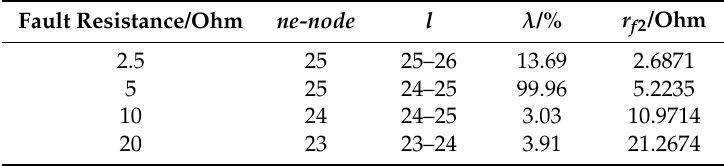
Table 17. Locating results of Strategy 2 with different fault resistances for Case